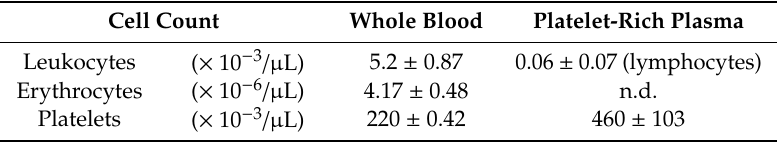
Table 1. PRP composition in terms of cell counts.